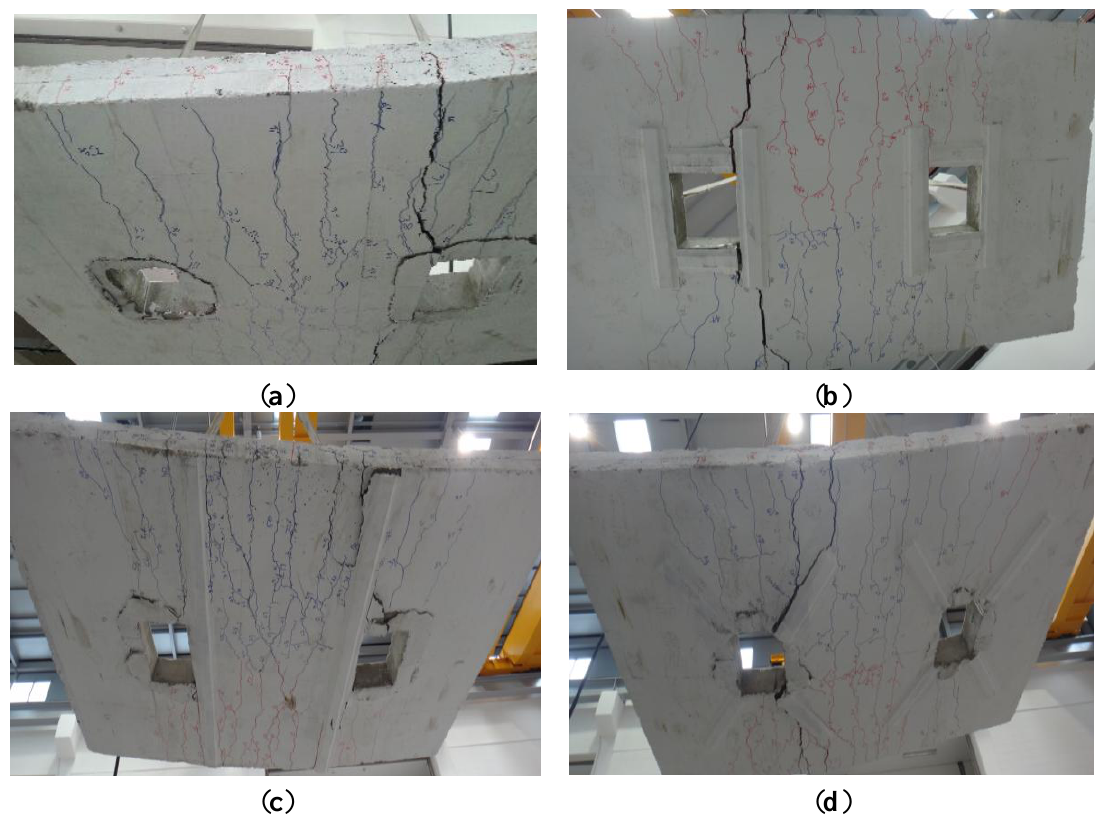
Figure 6. Failure Modes of ( a ) unstrengthened; ( b ) surround strengthening; ( c ) parallel strengthening; ( d ) diagonal